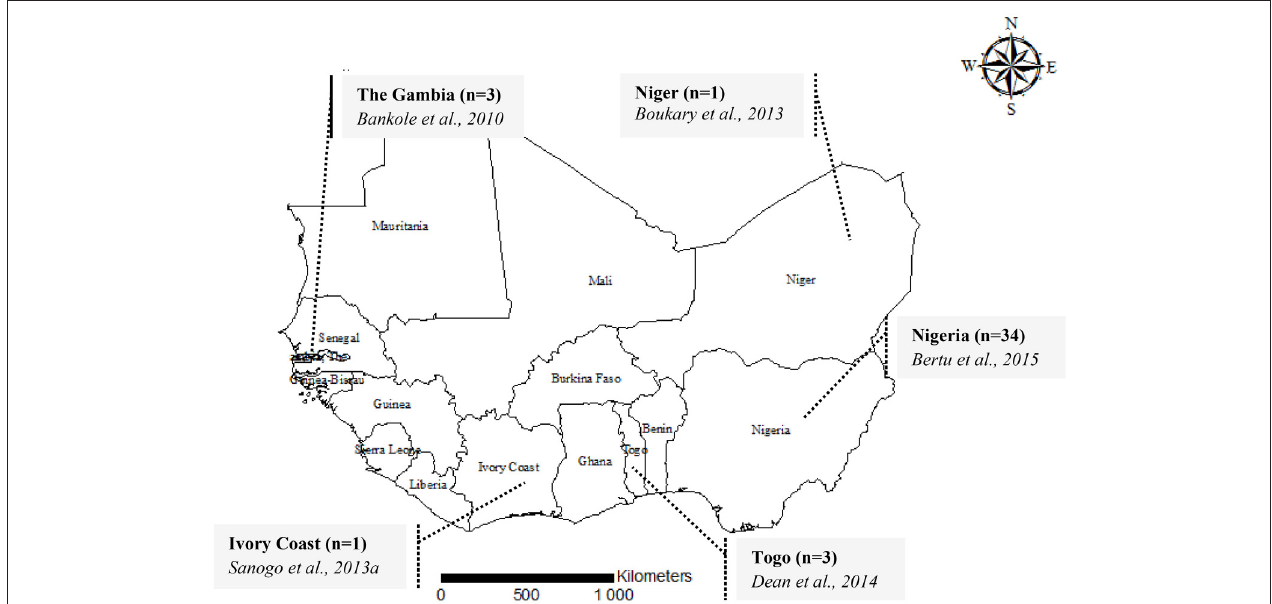
FIGURE 1 | A map showing the geographical origin of MLVA genotyping data of Brucella abortus biovar 3 in West Africa, 2015. For each country, the number of isolates genotyped [i.e., Ivory Coast ( n = 1)] is provided followed by the authors and the year of publication (i.e., Sanogo et al., 2013b).